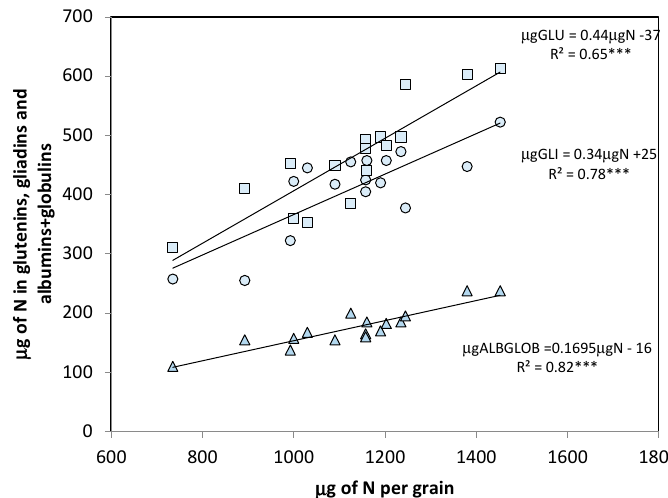
Figure 2. Relationships between the variation in the total grain nitrogen and the N content of the three protein fractions: glutenins (GLU) (squares), gliadins (GLI) (circles), and albumins-globulins (ALBGLOB) (triangles). Points are cultivar means across years and N treatments. *** p ≤ 0.001.